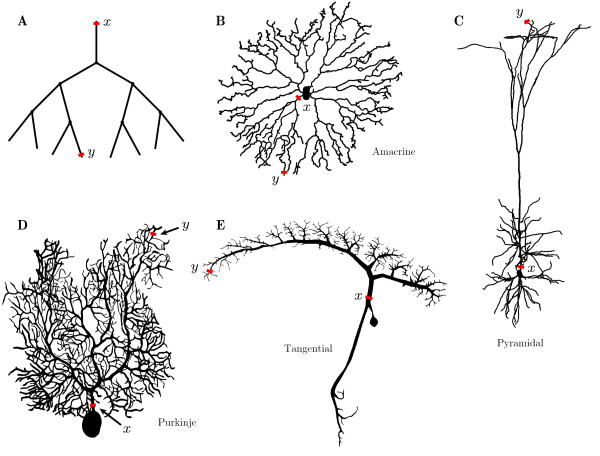
Neuronal structures used in construction of the Green’s function. A: a binary tree, B: a rabbit amacrine cell [28], C: a rat pyramidal cell [29], D: a rat Purkinje cell [30], and E: a blowfly tangential cell [31]